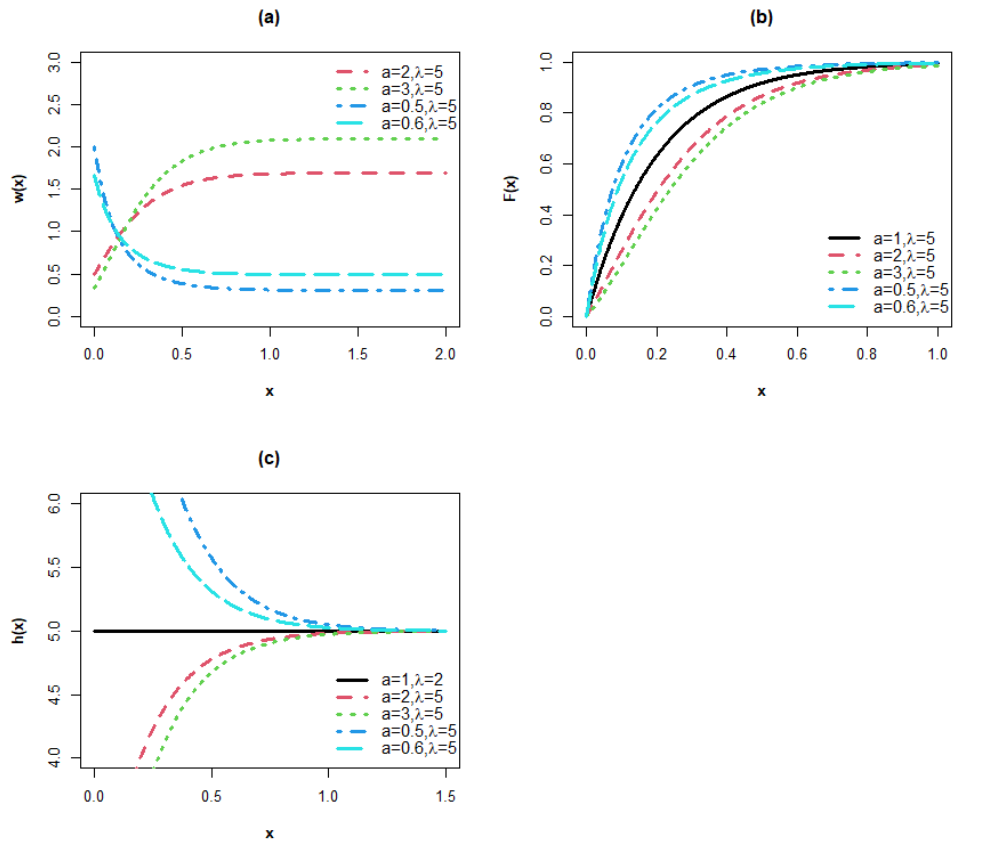
Figure 1. Plots of the ( a ) weight, ( b ) cdf and ( c ) hrf for the MPoE